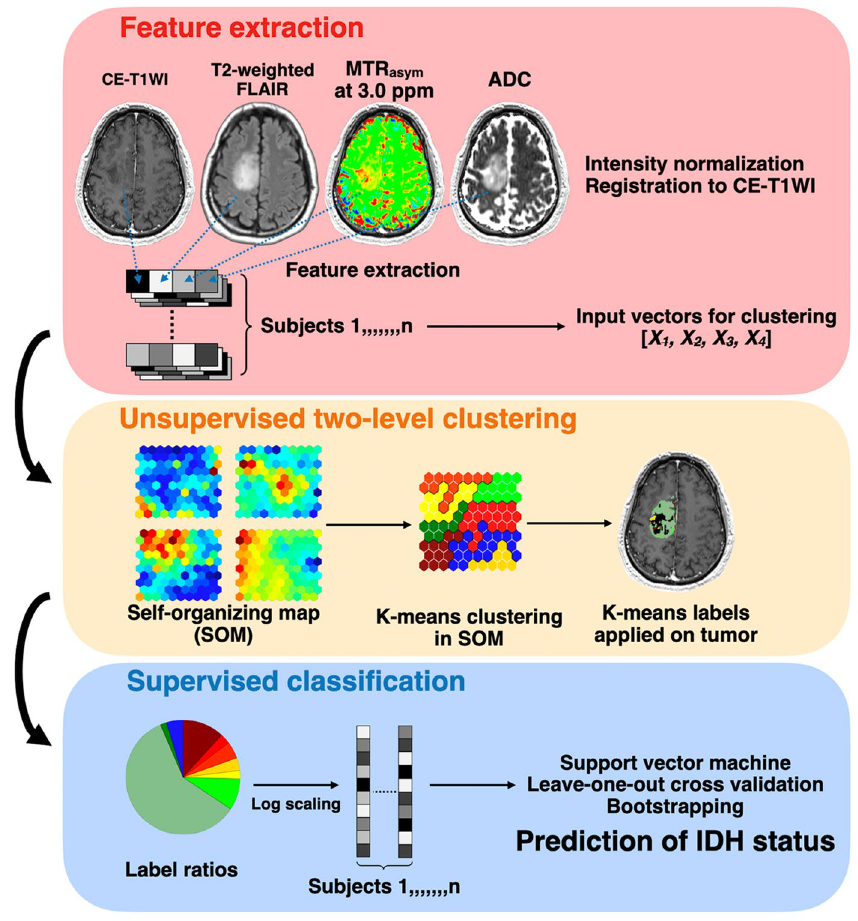
Figure 6. Graphical overview of the processing